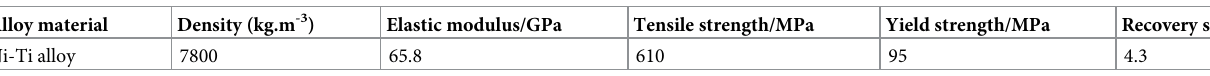
Table 2. SMA mechanical properties.